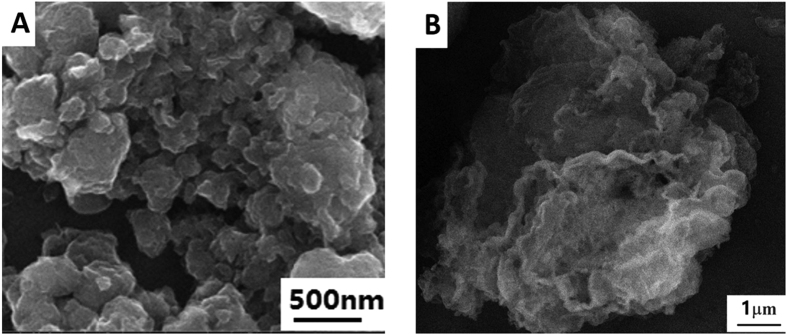
SEM of TiO2 nanosheets (A) and carboxylated g-C3N4 (B).